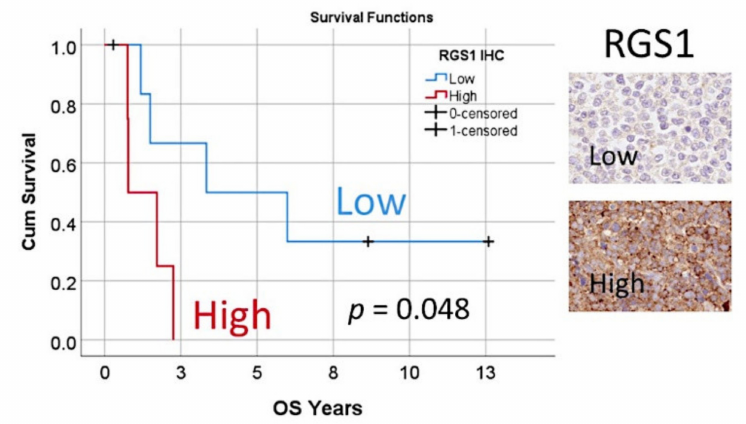
Figure 14. Overall survival according to the immunohistochemical expression of